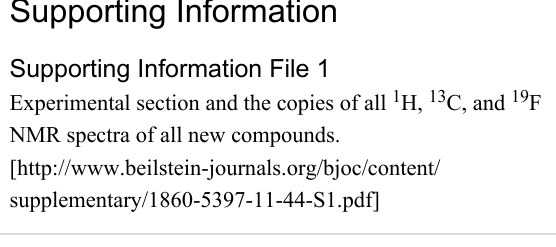
The preparation of compound 11 in the reaction of ester 1f with 5-AT was unexpected, because it is known that ester 1f inter- acts with 3-amino-1,2,4-triazole in refluxing ethanol [8] and with substituted 5-amino-1,2,4-triazoles in acetic acid [34] to afford triazolo[1,5- a ]pyrimidines. However, we did not observe the complete conversion of ester 1f in the reaction with 5-AT even under prolonged reflux in acetic acid. According to GC–MS data, the reaction mixture contained cyanoacetic ester ( 12 ) ( m / z 113 [ М ] + ) and ethyl 3-(1 H -tetrazol-5-ylamino)prop-2- enoate ( 13 ) ( m / z 182 [ М + 2] + ) along with ester 1f ( m / z 169 [ М ] + ) (Scheme